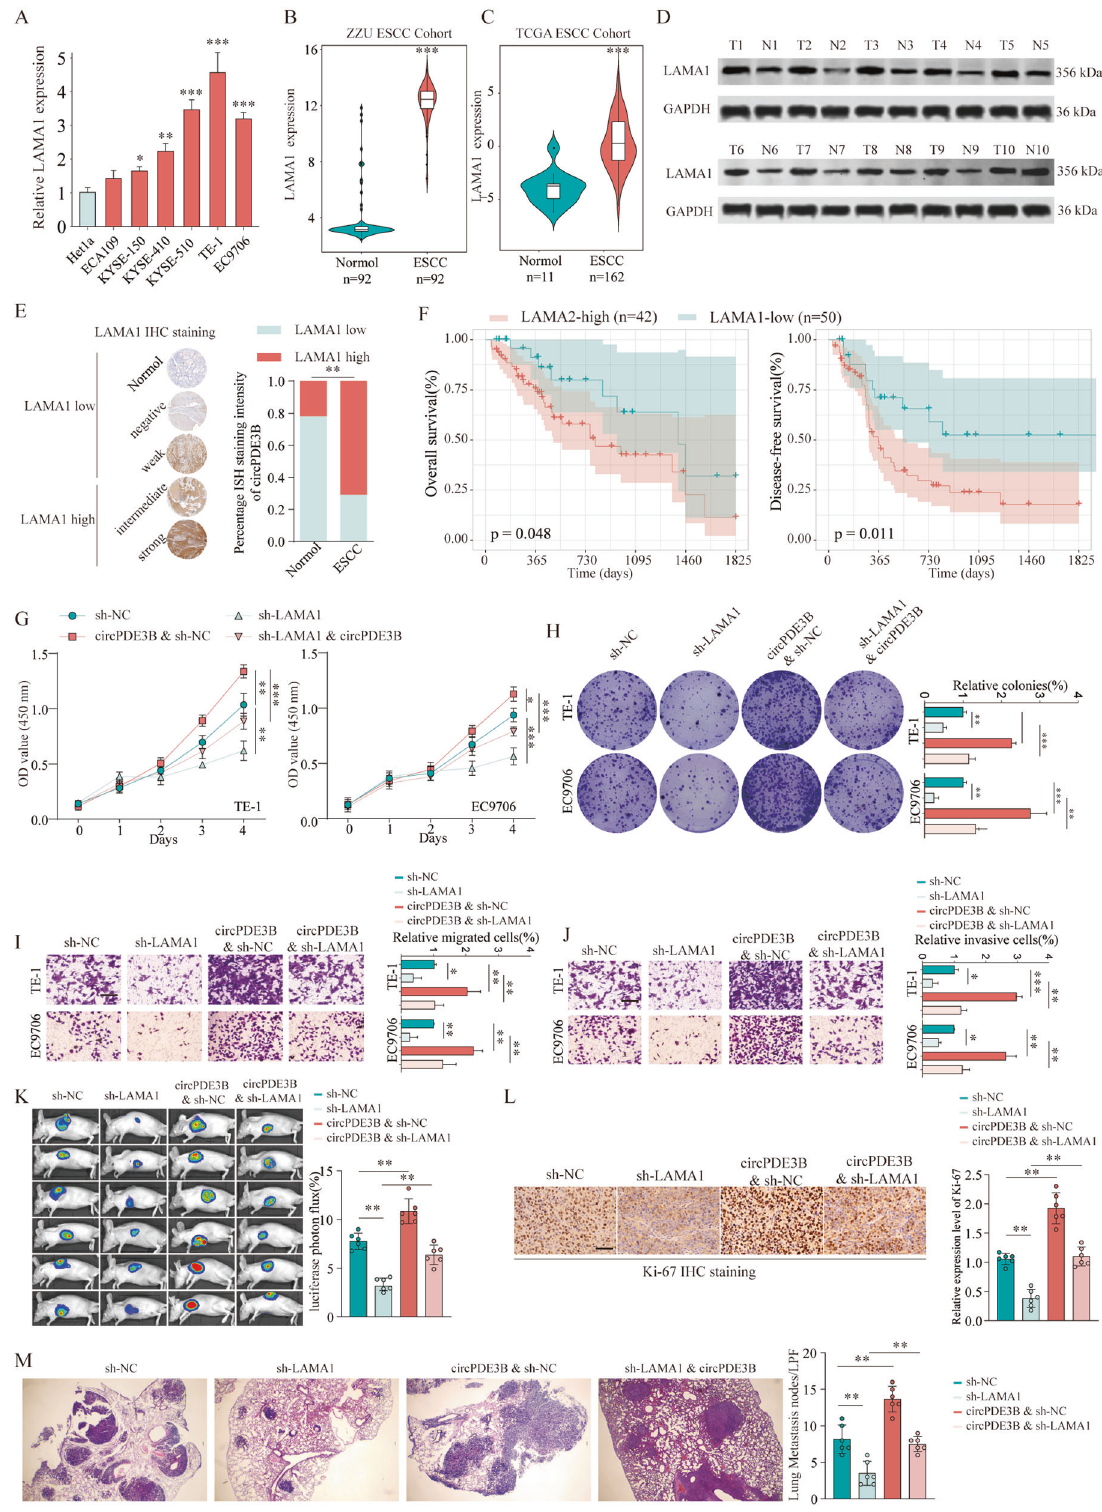
circPDE3B reintroduction (Fig. 7L). Interestingly, LAMA1 down- regulation greatly decreased metastatic tumor number and size, and the enforced circPDE3B expression again counteracted this change (Fig. 7M). Overall, our fi ndings show that the oncogenic role of circPDE3B is partly dependent on LAMA1.